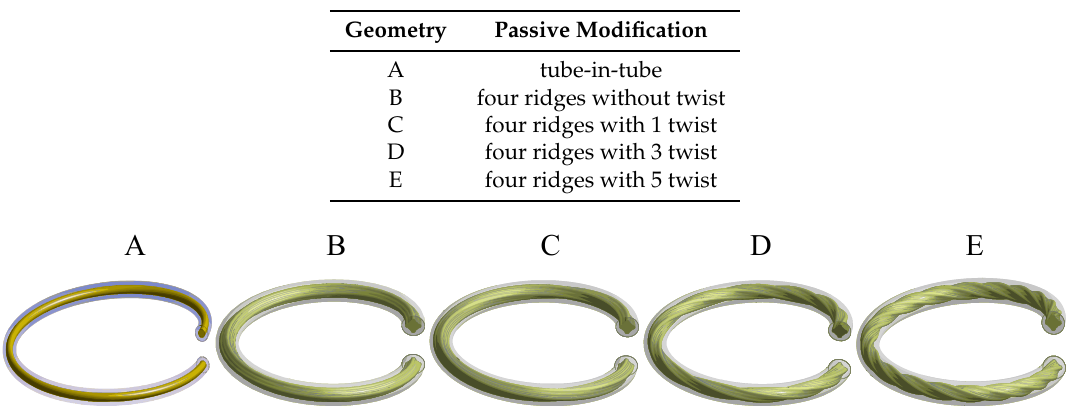
Table 2. Geometry of the five models presented in this work.